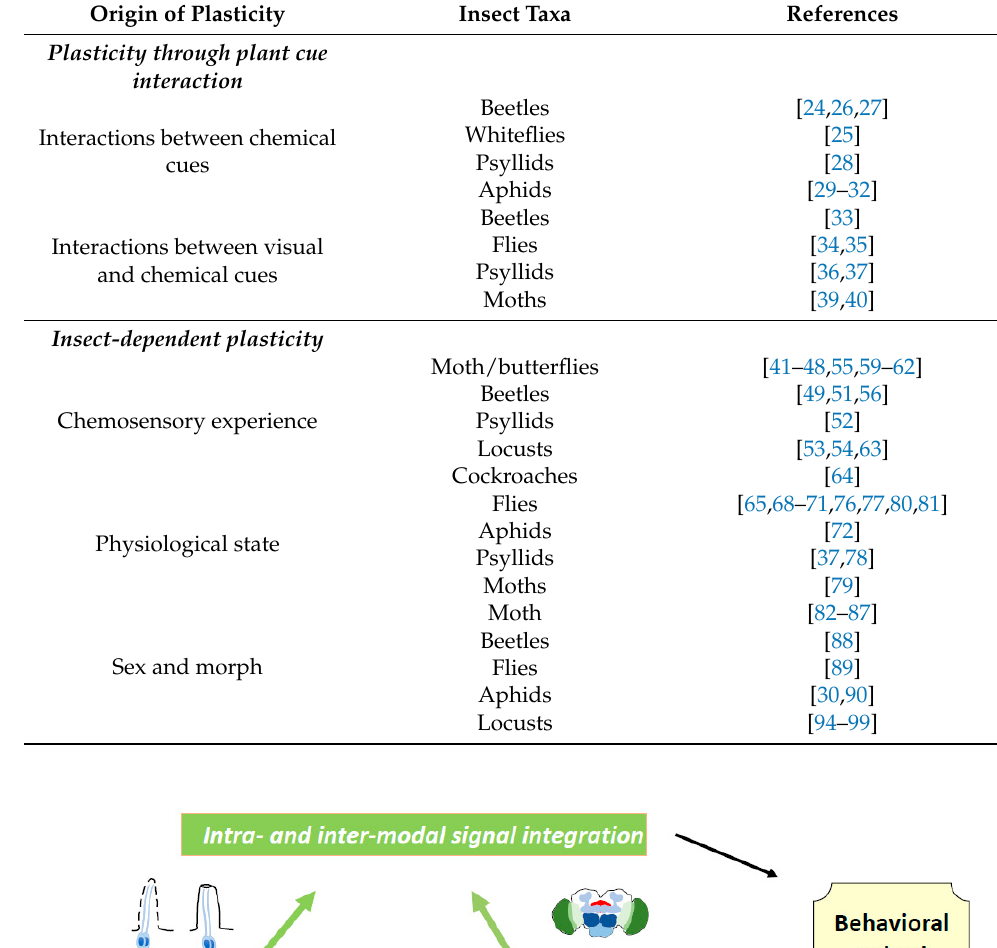
Table 1. Literature overview over different origins of chemosensory plasticity in host plant recog- nition of herbivorous insects .